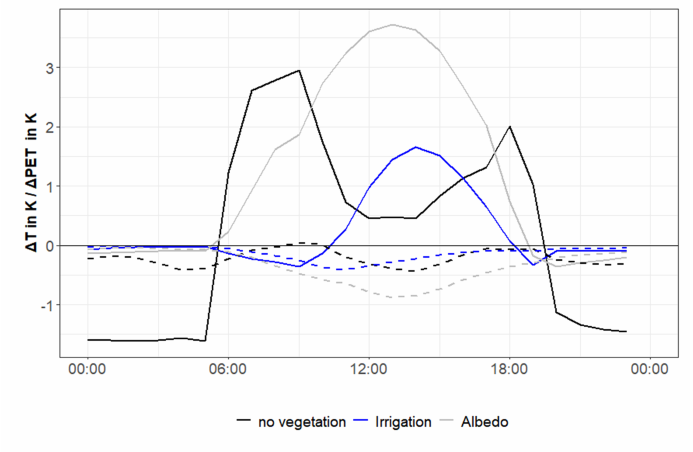
Figure 6. Diurnal variations of the total differences of the spatial mean values of PET (solid lines) and T a (dashed lines) for the climate adaptation scenarios compared to the current